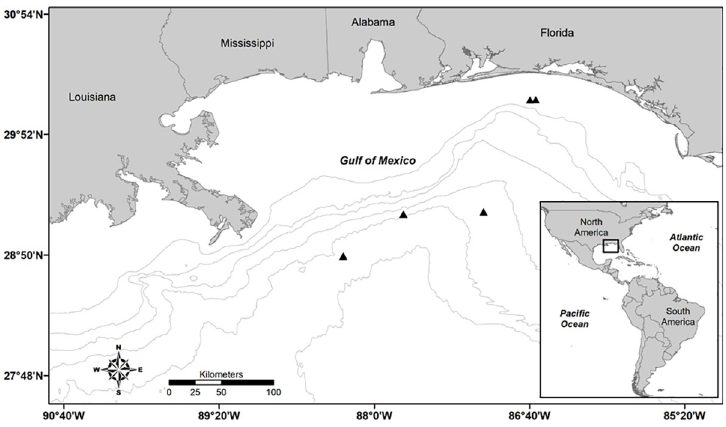
Fig 2. Northern Gulf of Mexico map showing water sampling locations. Map of DeSoto Canyon sampling locations in the northern Gulf of Mexico (black triangles) where water samples were taken for analysis of dissolved inorganic carbon Δ 14 C. The 50, 100, 200, 500, 1000 and 2000 m isobaths are shown. The thicker line is the 200 m isobath, which is the depth where the outer continental shelf ends and the slope waters begin. This map was made using ArcGIS software.